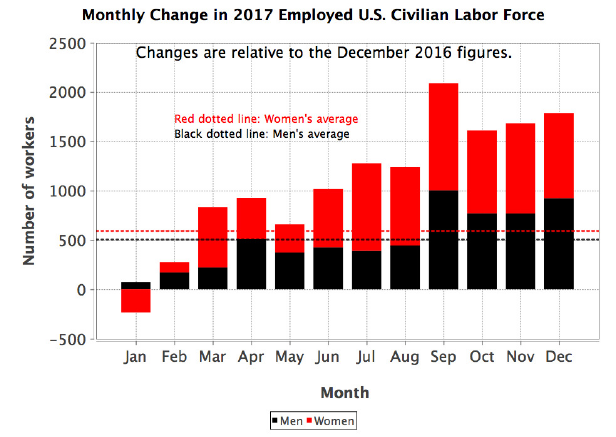
Figure 3. Example 2D stacked-bar chart made by Thoth. This counterpart of the regular bar chart is useful for visualization of orthogonal categories that can be added to sum up a more general population (such as “females” plus “males” give total or net number of